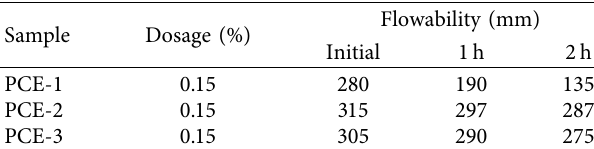
Table 3: Paste flowability of PCE-1, PCE-2, and